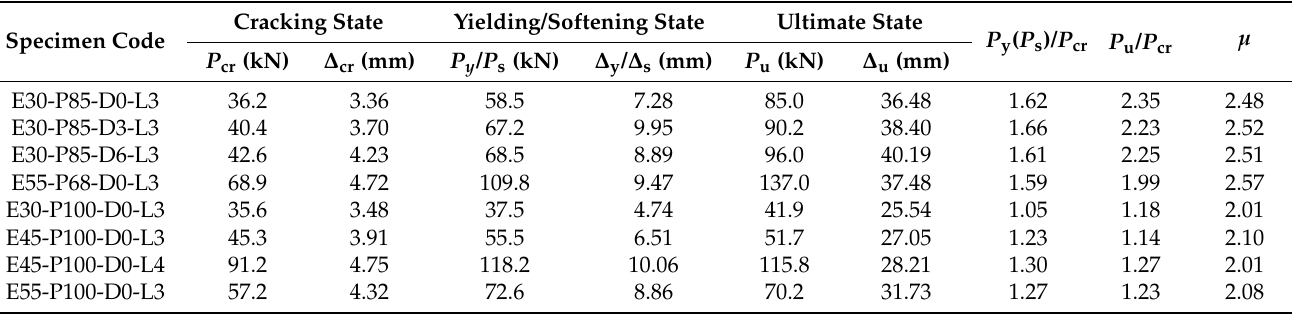
Table 3. Experimental results for specimens.